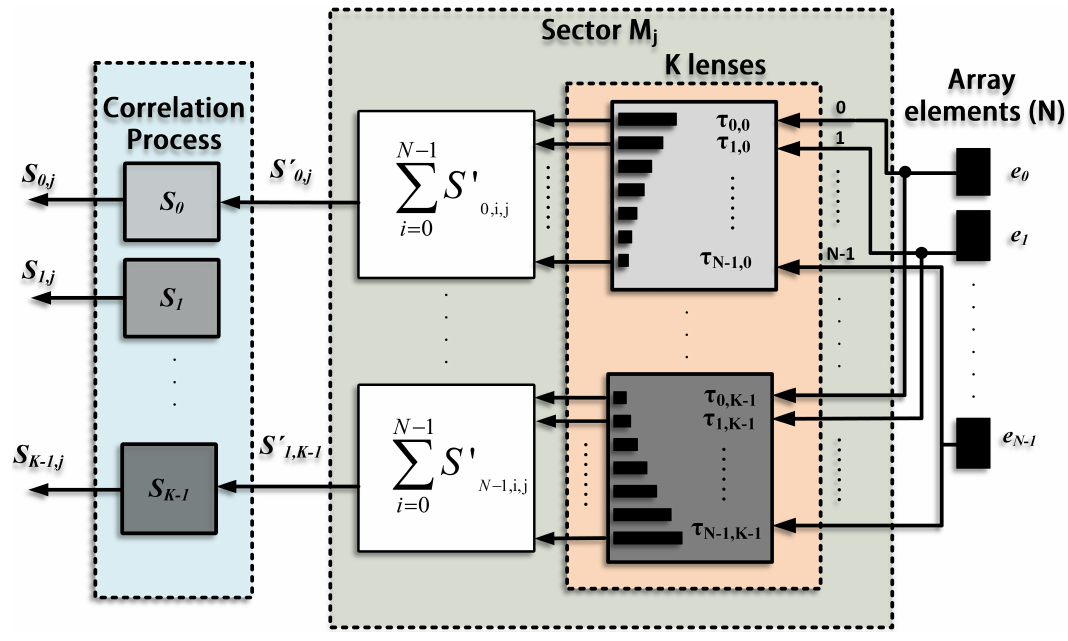
, K different lens τ are applied. j ) are obtained, each one linked i =0 , 1 ,...,K − 1; j